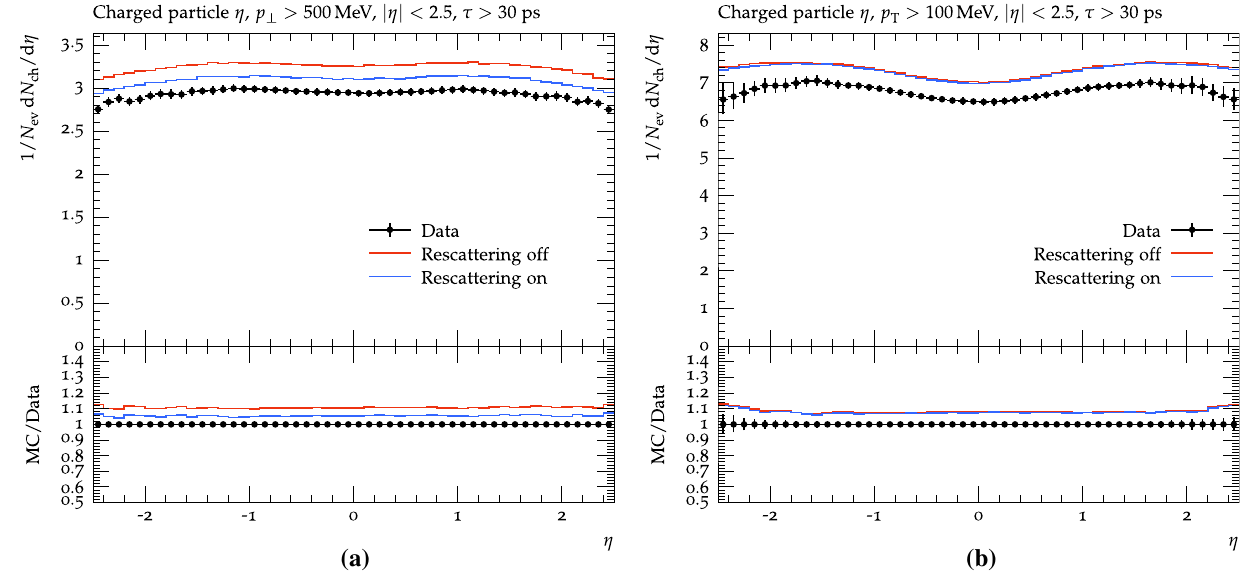
Fig. 19 Charged particle η spectra compared with data from ATLAS [79,80], with cuts a p ⊥ > 500 MeV, and b p ⊥ > 100